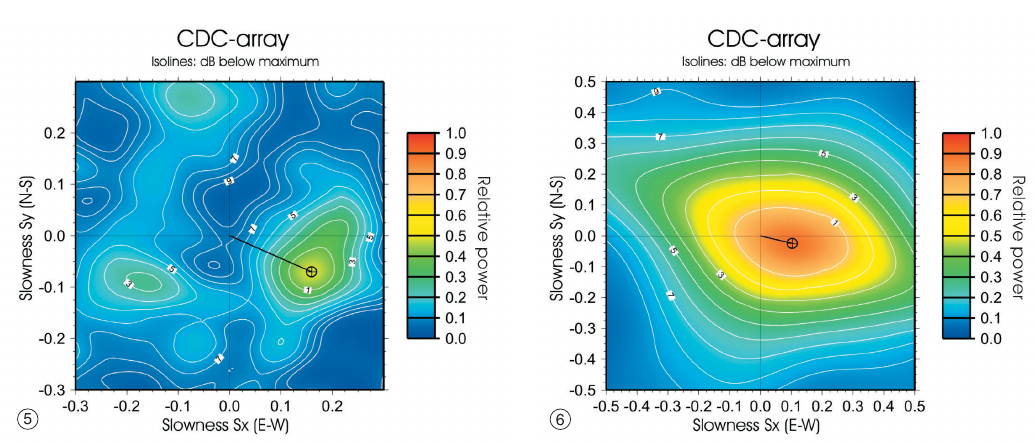
Fig. 5. F - k analysis based on the nine bandpass filtered (2.0-6.0 Hz) vertical traces of a local seismic event ( M L = 1.8) occurred at 40 km ESE from the CDC-array. The maximum peak level (relative power 0.48) is found for v app = 5.74 km/s and backazimuth = 113.7°). Fig. 6. F - k analysis of the nine bandpass filtered (0.8-2.5 Hz) vertical records of a regional seismic event ( M L = = 3.5), located in the Greece-Albania border region. For the maximum peak level (relative power = 0.88) an ap- parent velocity of v app = 9.43 km/s was determined, reaching the array from a backazimuth of